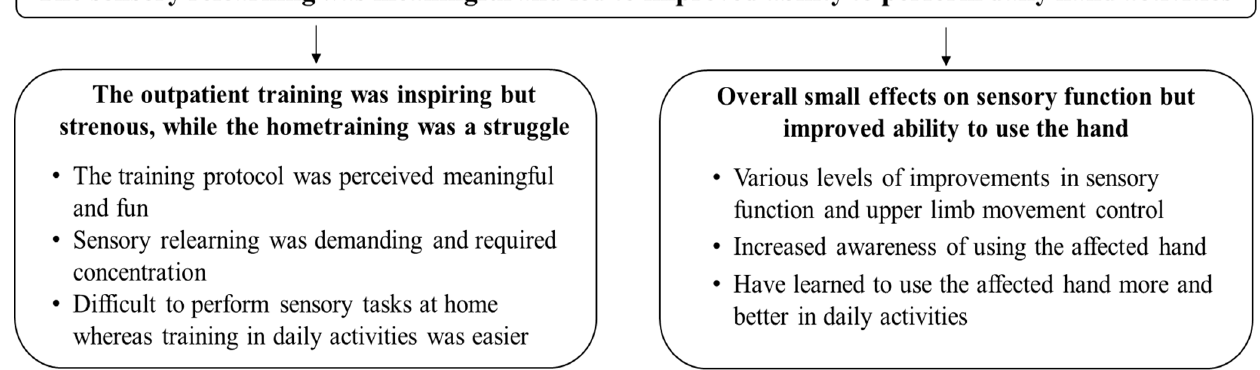
Figure 1. An overview of the overall theme, categories, and subcategories.